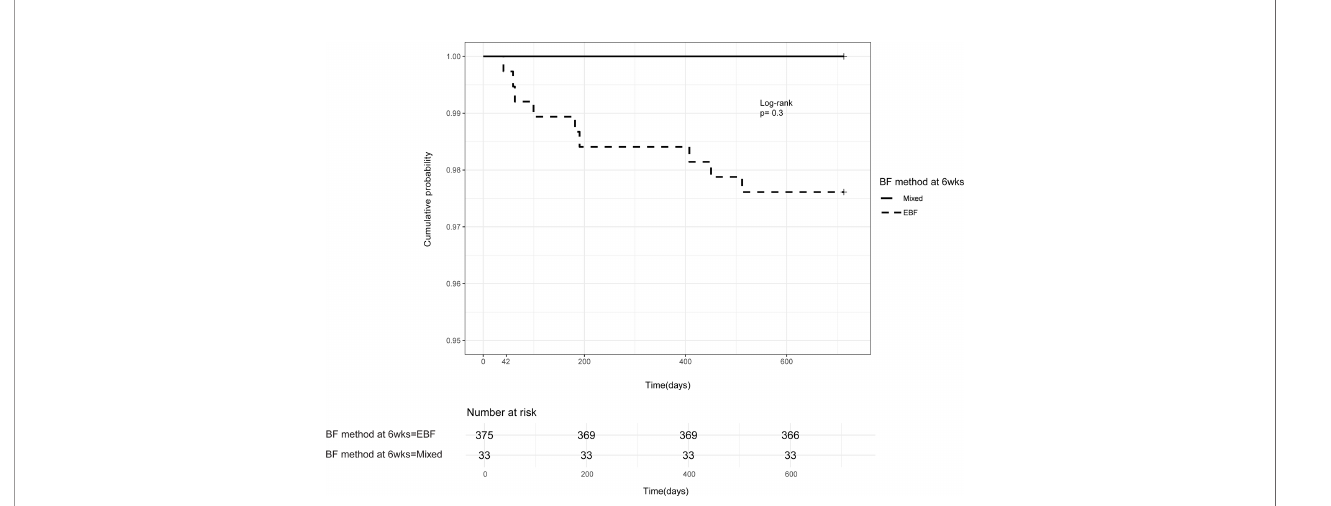
FIGURE 4 | Postpartum HIV mother-to-child-transmission. Kaplan – Meier probability of postpartum HIV transmission in infants born of women already HIV-infected during pregnancy and one woman infected postnatally — based on the method of infant feeding at the 6 weeks follow-up visit. EBF, exclusive breastfeeding; mixed, breastfeeding and complimentary